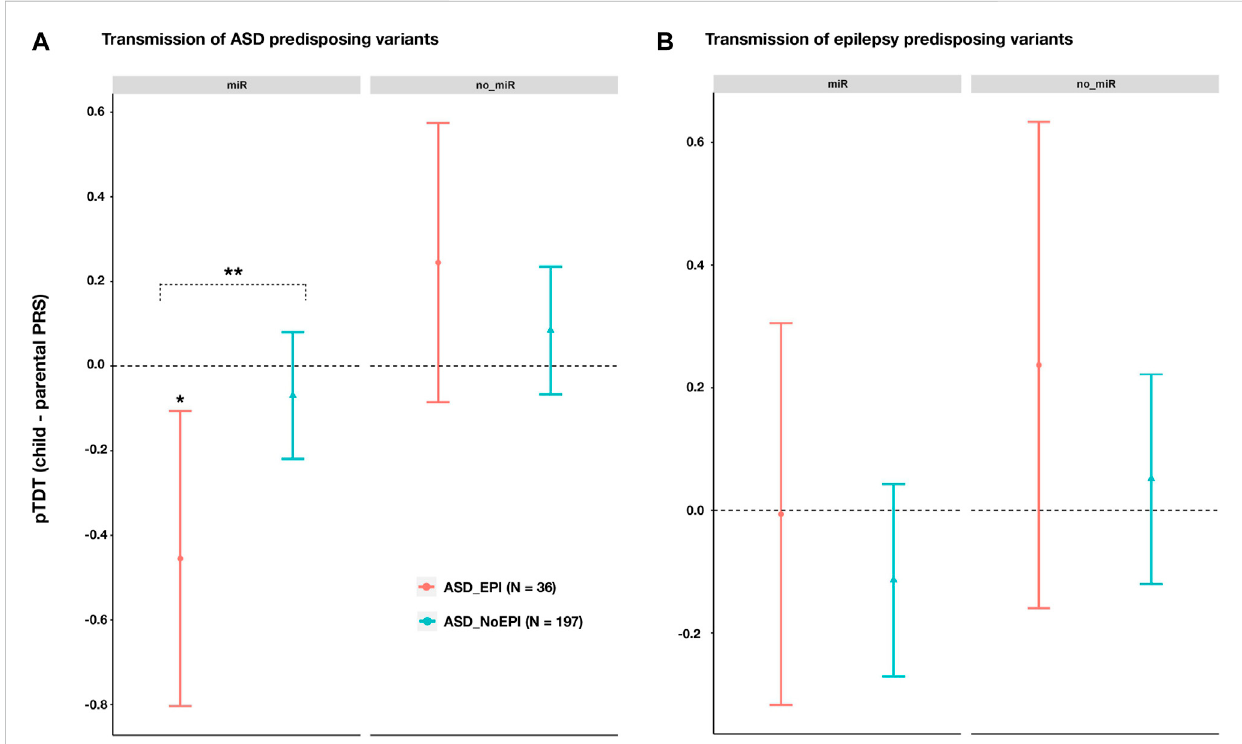
FIGURE 3 Polygenictransmissiondisequilibriumtest(pTDT)onASDandepilepsyriskvariantsinASDtrioswith(ASD_EPItrios,N=36),andwithout(ASD_NoEPI trios;N=197)comorbidepilepsy.Two-tailedt-testswereperformedtotestforoverorunder-transmissionofcommonpredisposingallelestoASD (A) or epilepsy (B) , from parents to children (Supplementary Data Sheet S7). Common predisposing variation across genes targeted (miR; N = 4,581 genes) or not targeted (no_miR; N = 18,895 genes) by the 14 selected miRNAs. Error bars represent 95% con fi dence intervals. For each disorder and genomic partition, we selected the most signi fi cant p -value threshold from the pTDT previously performed in the whole sample of ASD trios (Supplementary Data Sheet S7). (A) pTDT on ASD predisposing variants (B) pTDT on epilepsy predisposing variants. Signi fi cant p -values from permutation analyses are marked with an asterisk. two sample t -test was performed to evaluate differences in pTDT between ASD_EPI and ASD_noEPI subsamples.